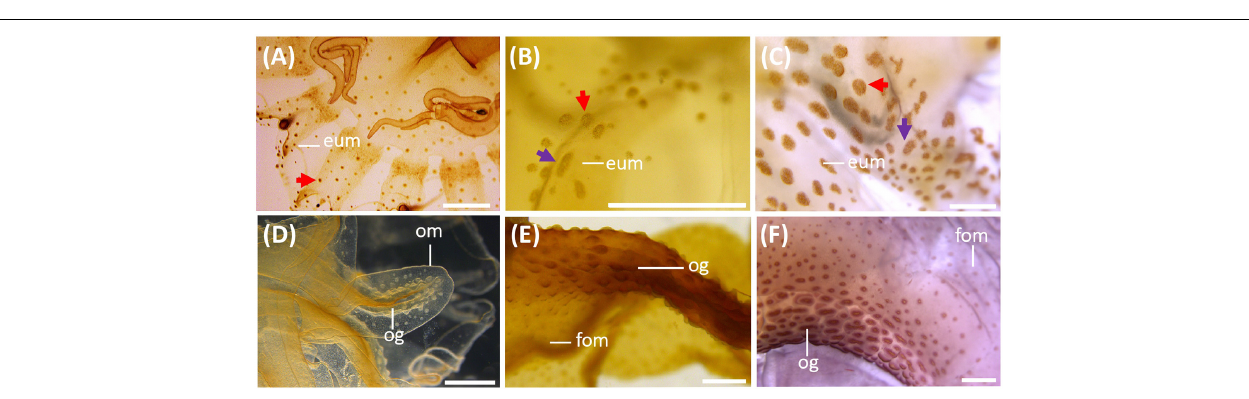
( Table 2 ). Euryteles are the only nematocyst type in the gastric filaments ( Table 2